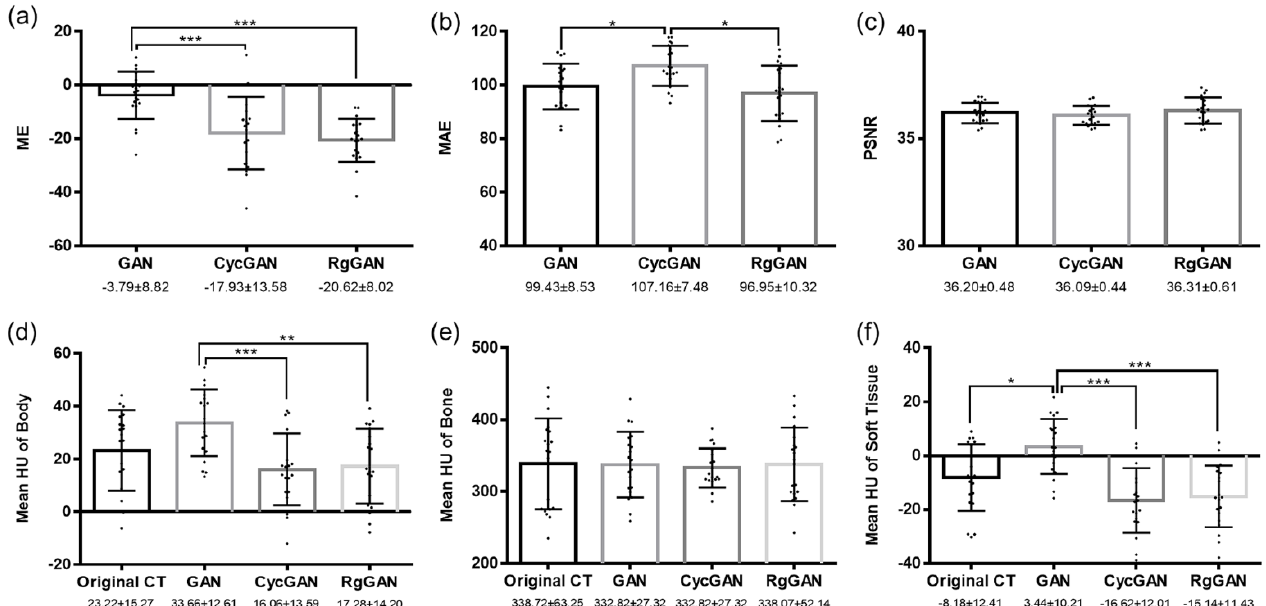
Figure 3 . Comparison of mean error ( a ), mean absolute error ( b ), and peak signal-to-noise ratio ( c ) and mean Hounsfield units of original computed tomography and synthetic computed tomography for body ( d ), bone ( e ), and soft tissue ( f ) according to the deep learning techniques. Abbreviations: GAN, generative adversarial network; CycGAN, cyclo-consistent generative adversarial network; RgGAN, Reference-guided cyclo-consisten generative adversarial network; ME, mean error; MAE, mean absolute error; PSNR, peak signal-to-noise ratio. * 0.01 < p < 0.05, ** 0.001 < p < 0.01, *** p < 0.001.